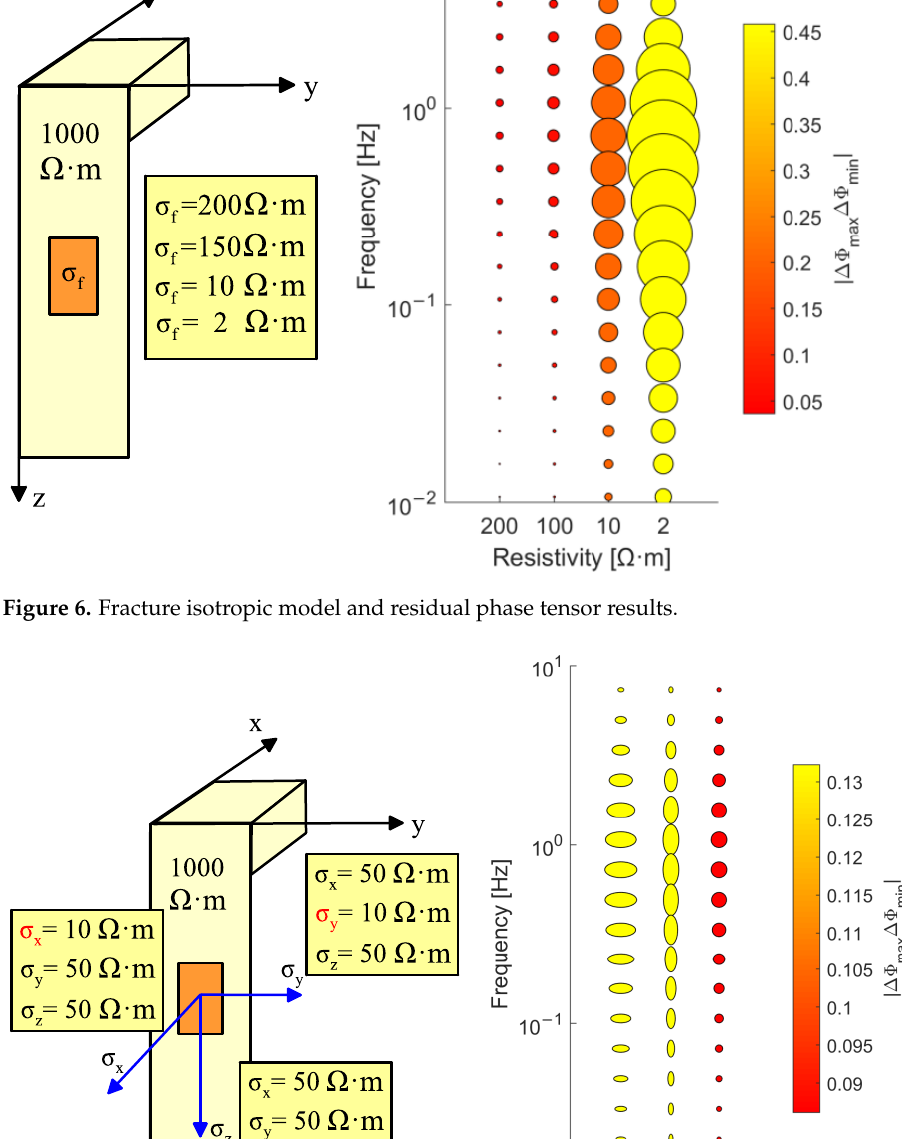
Figure 7. Fracture anisotropy model and the residual phase tensor with the change of the conductivity axis.